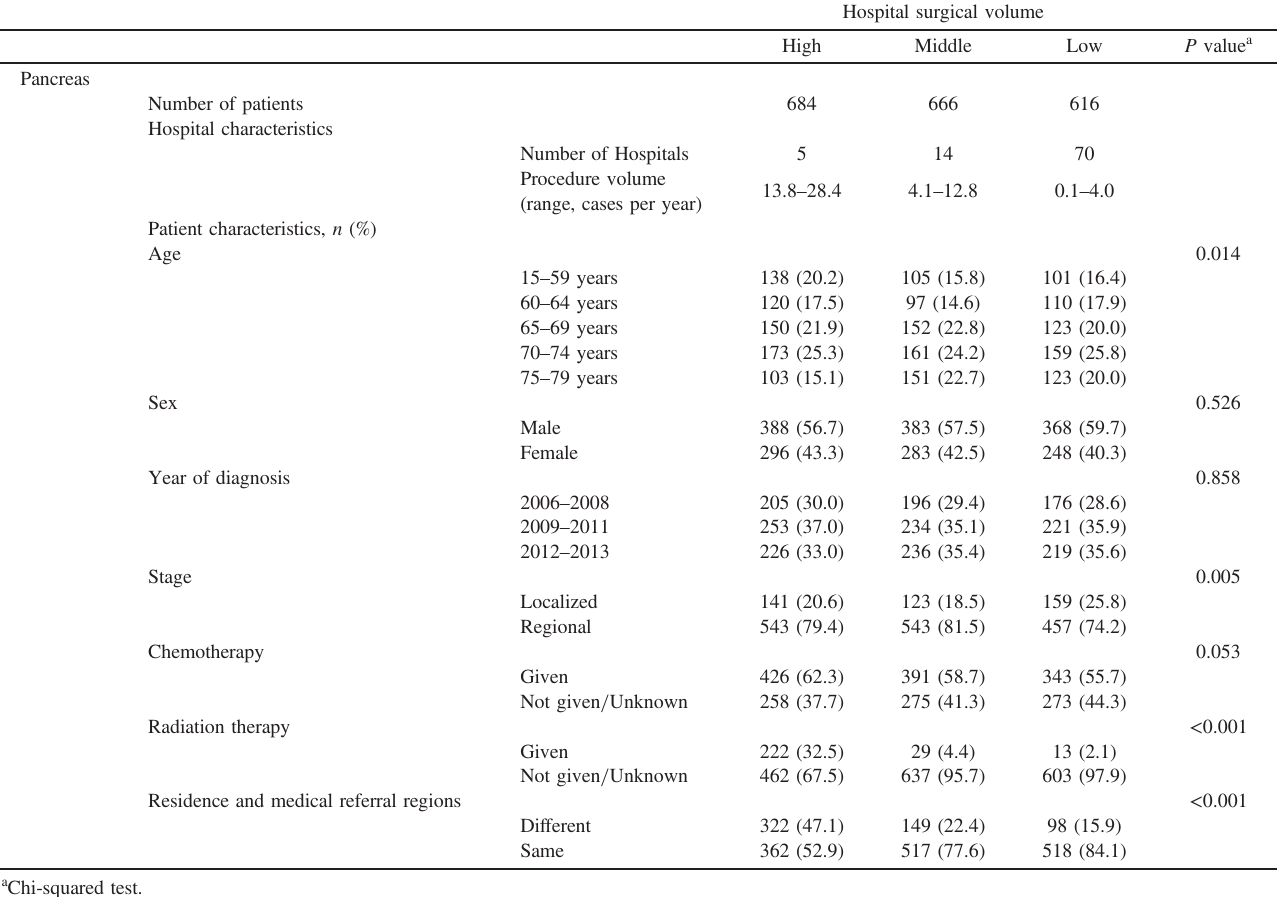
Table 3. Characteristics of pancreatic cancer patients undergoing curative surgery at high-, middle-, and low-volume hospitals, based on data from the 2006 – 2013 Osaka Cancer Registry Database ( n = 1,966)